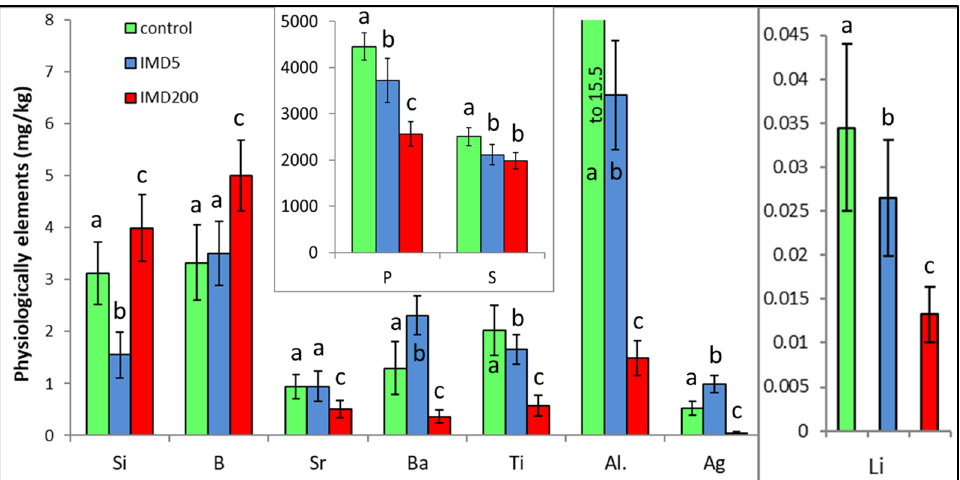
Figure 6. Body levels (mean ± SD) of the physiologically essential bioelements in honey bee workers exposed and unexposed to imidacloprid. Explanations: control = the bees were fed a diet without imidacloprid; IMD5 = the bees were fed a diet with a 5 ppb addition of imidacloprid; IMD200 = the bees were fed a diet with a 200 ppb addition of imidacloprid. Different lowercase letters = differences between the means nested within each bioelement are significant (ANOVA + LSD; p < 0.05). Generally, the values of PC1 or PC2 were higher than |0.8| for 26 out of the 32 bioele-